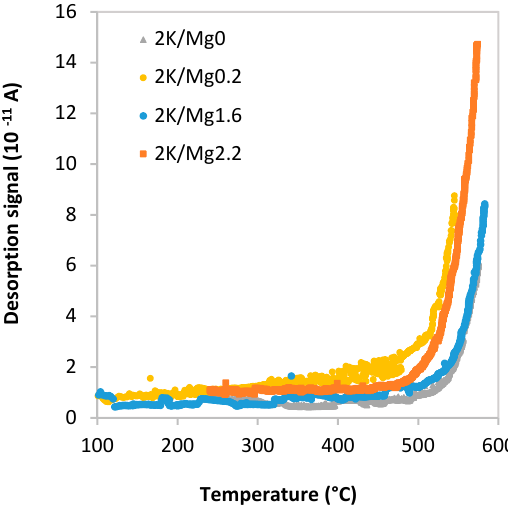
Figure 9. Atomic K desorption flux as a function of temperature.